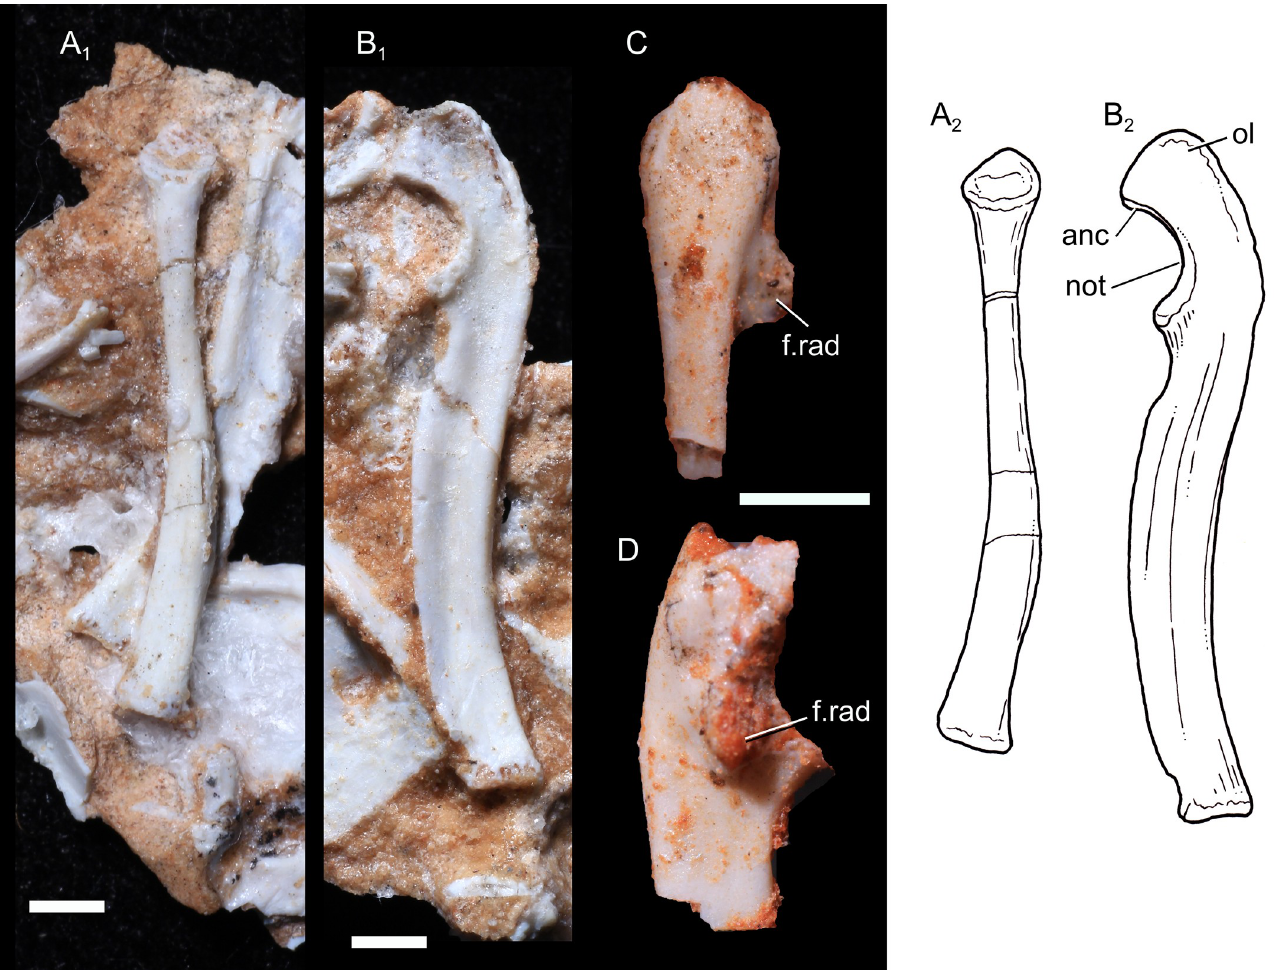
Fig 4. Forearm of Brasilodon quadrangularis . A , photography (1) and drawing (2) of the left radius (UFRGS-PV-1043-T), in medial view; B , photography (1) and drawing (2) of the right ulna (UFRGS-PV-1043-T), in medial view; C , photography of the right ulna (UFRGS-PV-0765-T), in posterior view; D , same material, in lateral view. Abbreviations: anc , anconeal process; f.rad , facet for the radial head; not , notch for the ulnar condyle; ol , olecranon. Scale bar = 2 mm.